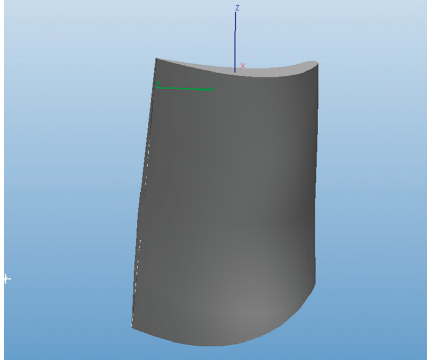
Figure 16: The shape of the substrate surface.